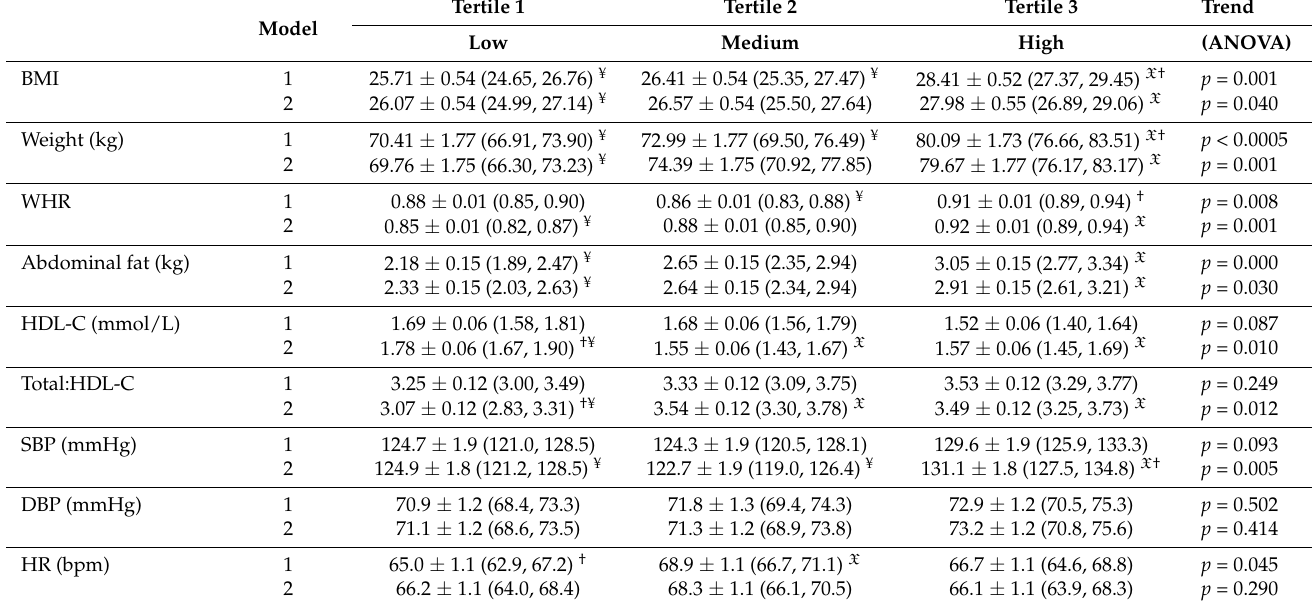
Table 2. Baseline values for MedLey outcome variables per DII tertile.